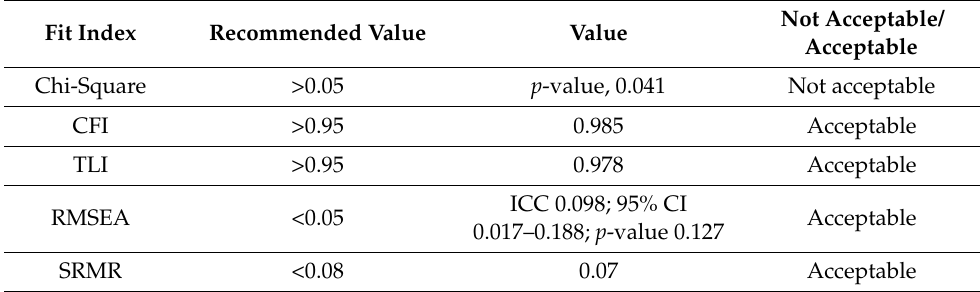
Table 2. Confirmatory factor analysis fit indices for the one-factor model.